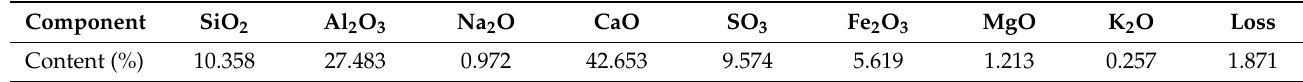
Table 1. FISC chemical composition.